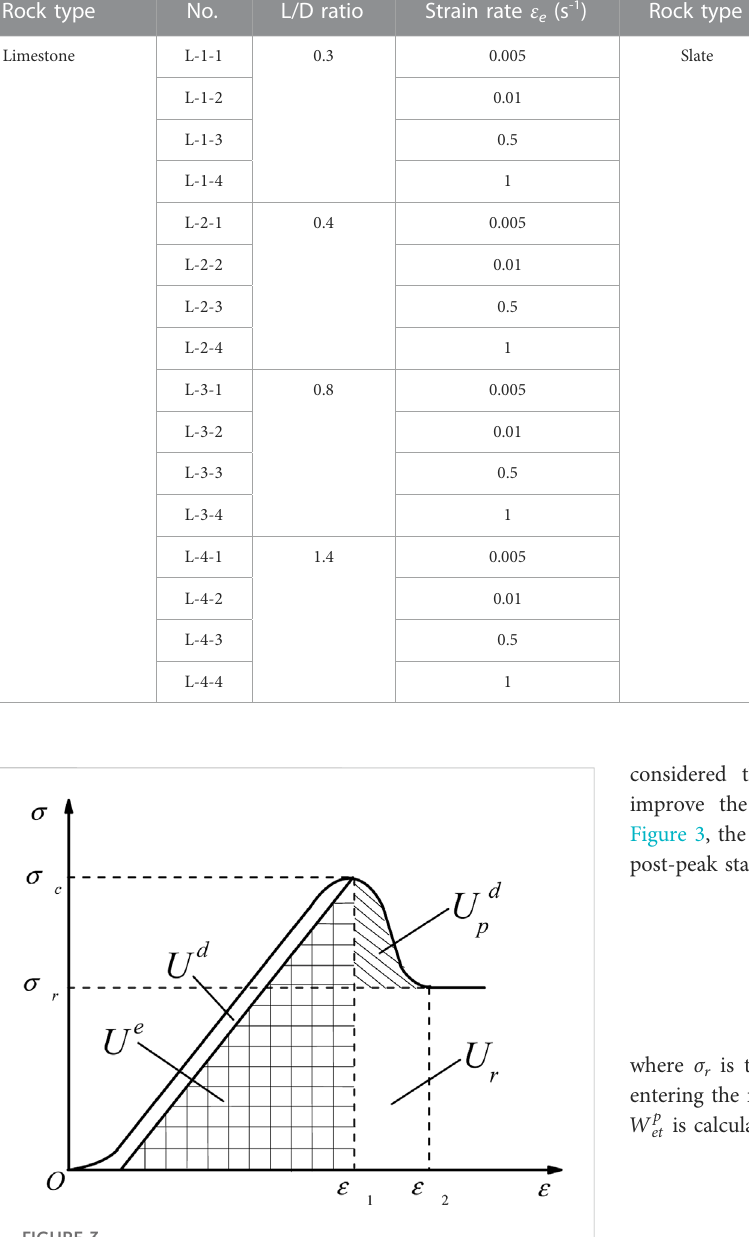
TABLE 1 Test method and sample serial number. Rock type